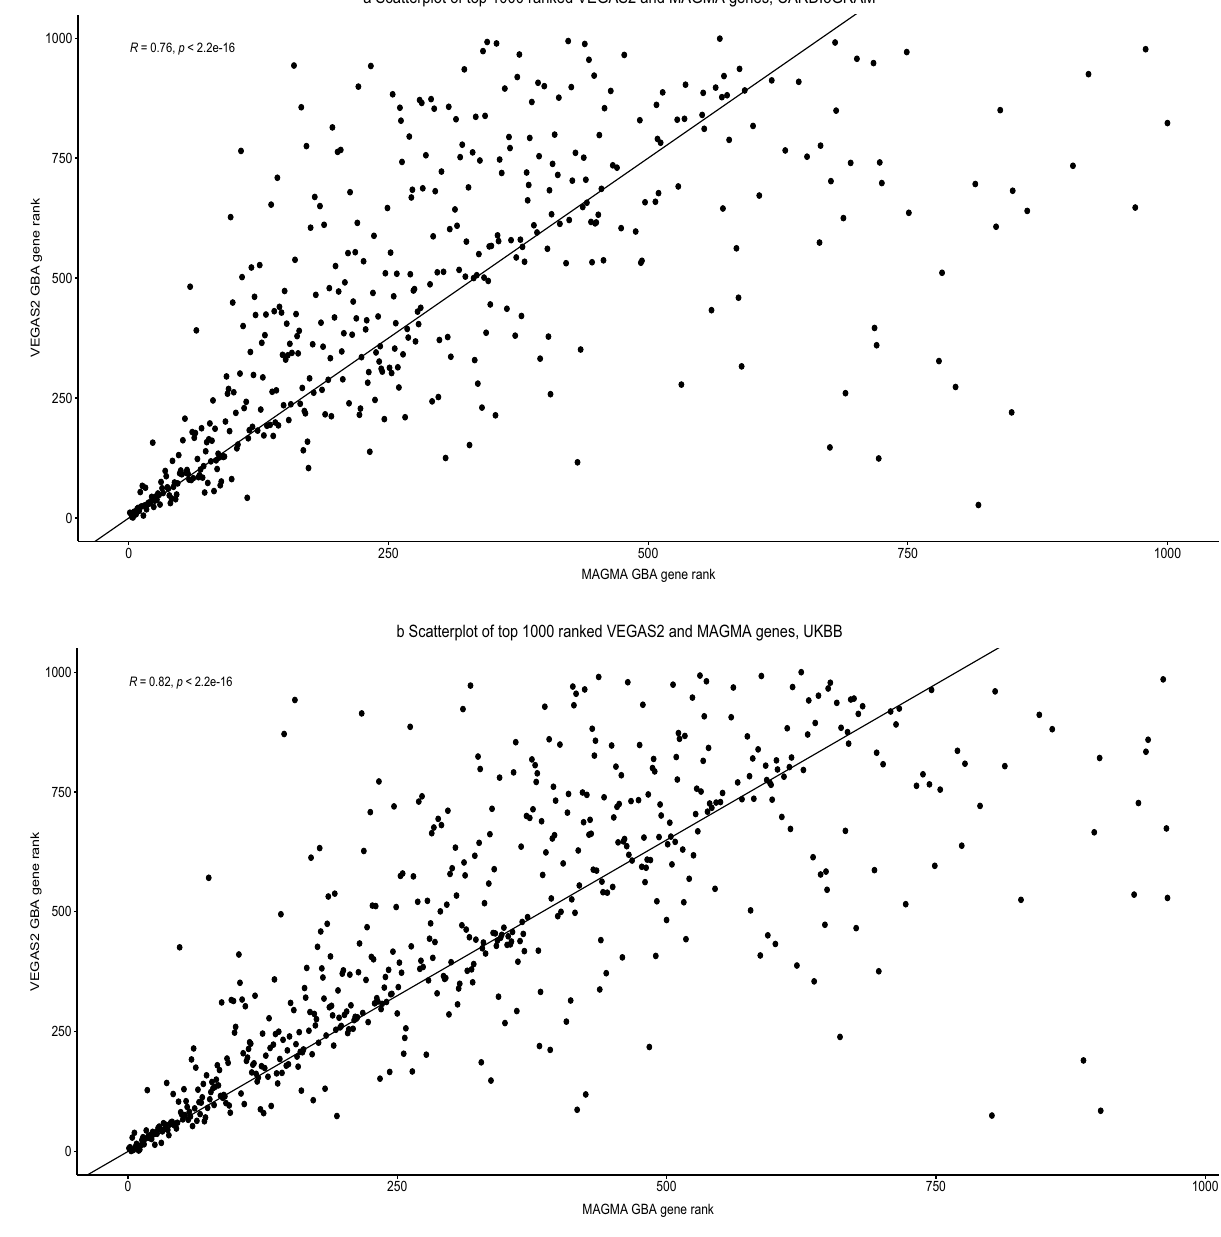
Figure 3. Scatter plot of VEGAS2 and MAGMA ranked genes. R Spearman correlation coefficient, GBA gene based association